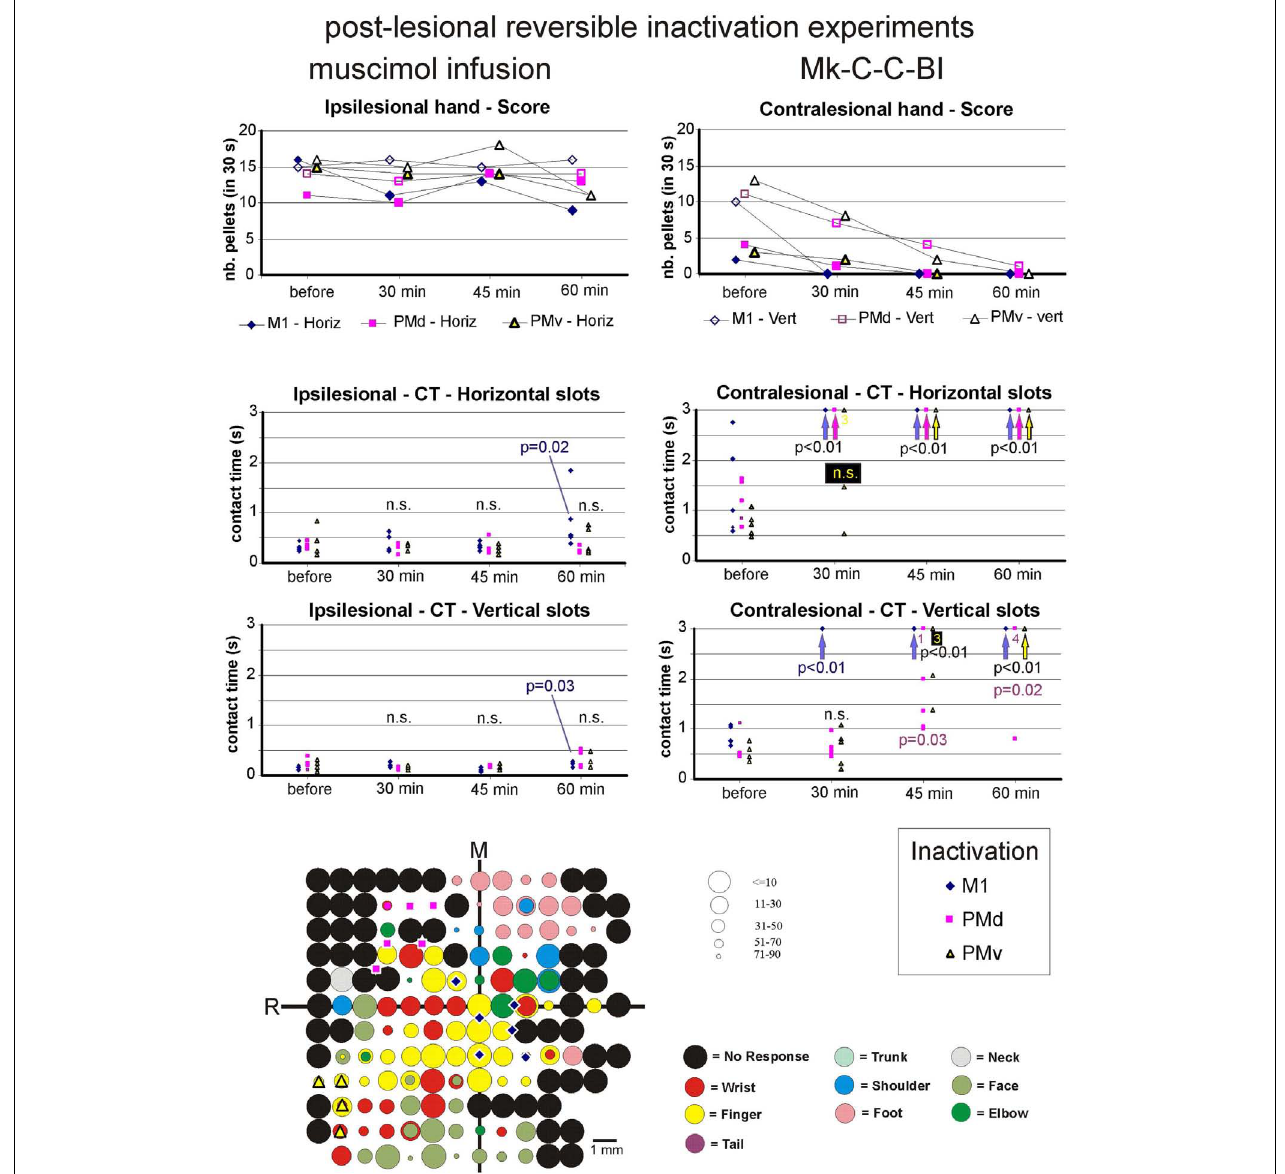
was unable to grasp the pellet from the aimed slot).Vertical arrows below the data points at 3s indicate that all five first attempts were unsuccessful (or took more than 3s): in such a case, the difference compared to Reference performance (before infusion of muscimol) was highly statistically significant ( p < 0.01; Mann andWhitney test). In some cases, numbers below the data points saturated at 3s indicate how many observations were indeed equal to or longer than 3s. At each time point and for each inactivation session (M1, PMd, or PMv: see color code in the bottom inset), there are five data points when the monkey performed the task successfully (in some cases, two data points may overlap).The contact time values at each of the three time points after infusion of the muscimol (30, 45, and 60min) were statistically compared with those obtained before infusion of muscimol (reference manual performance). Using the same color code as the symbols, when the difference was statistically significant, the corresponding p value is indicated, whereas “n.s.” means that the difference was not statistically significant ( p > 0.05).When a single p value or “n.s.” is indicated, it means that it holds true for the three inactivation sessions (M1, PMd, or PMv). At the bottom